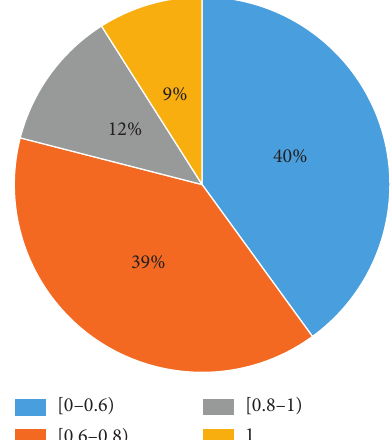
Figure 12: The proportion of coordinated development index θ ′ of traffic level to built environment.